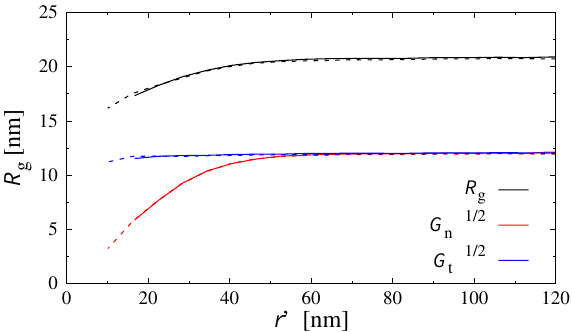
Figure 5. Radial profiles of the radius of gyration of monodisperse Dextran, R g , and its normal ( (cid:104) G n (cid:105) 1/2 ) and tangential ( (cid:104) G t (cid:105) 1/2 ) components relative to the droplet surface. Data plotted against the distance between the droplet surface and the polymer’s center of mass, r (cid:48) . Solid and dashed lines show results for R ≈ 260nm and R ≈ 380nm,